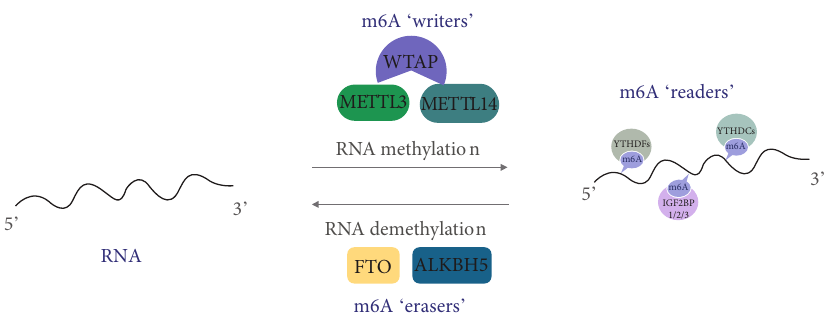
Figure 5: The dynamic and reversible processes of m6A methylation. m6A RNA methylation is mainly regulated by its “ writers, ” “ erasers, ” and “ readers. ” Writers refer to the m6A methylase complex including METTL3, METTL14, and WTAP. Erasers are m6A demethylases involving FTO and ALKBH5. Readers include the YTH domain family (YTHDFs and YTHDCs) and IGF2BP1/2/3 family. “ Writers ” deposit m6A methylation on RNAs, while “ erasers ” remove the m6A marks. “ Readers ” can directly bind to m6A to mediate downstream processes including mRNA export and mRNA